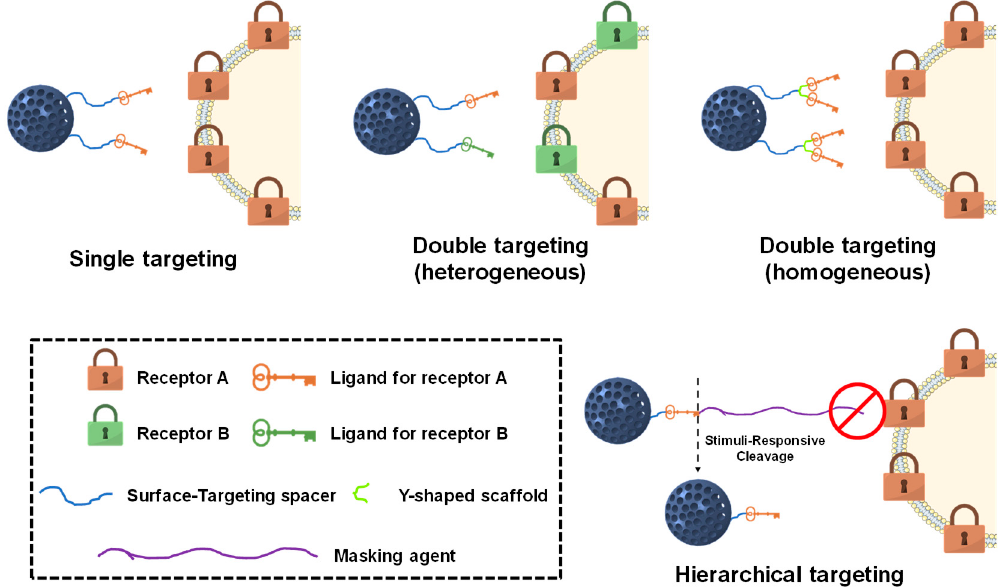
Figure 5. Schematic representation of the most common targeting approaches using MSNs.